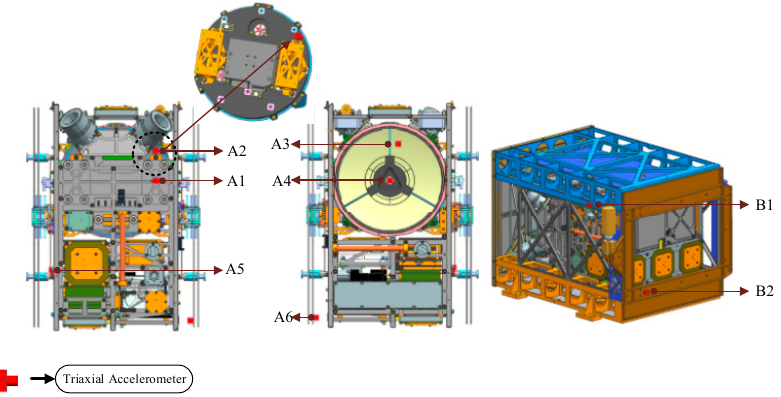
Figure 11. The arrangement of three-axis accelerometers. Table 6. Random vibration test conditions.